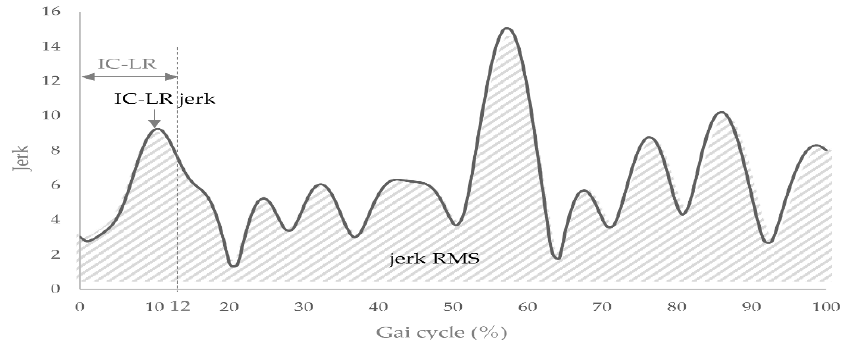
Figure 1. Methods for calculating jerk RMS and IC-LR jerk. Abbreviations: RMS, Root Mean Square; IC-LR, Initial Contact — Loading Response.